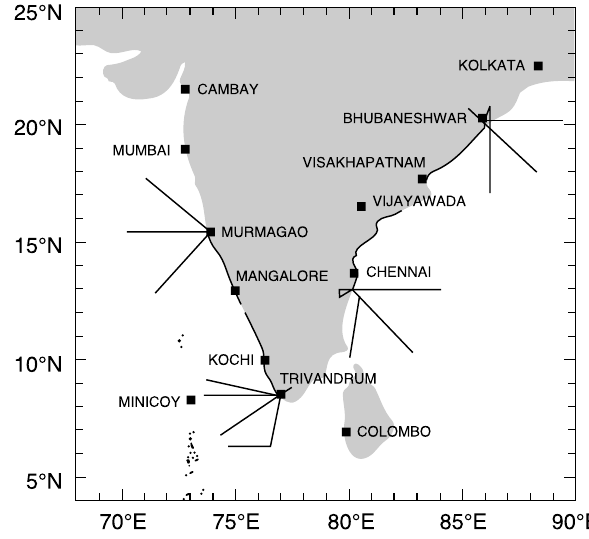
Fig. 15. Flight tracks of the Indian NRSA Beechcraft 200 during the ICARB campaign (redrawn from Moorthy et al., 2008, copy- right 2008 by the Indian Academy of Sciences, reproduced with